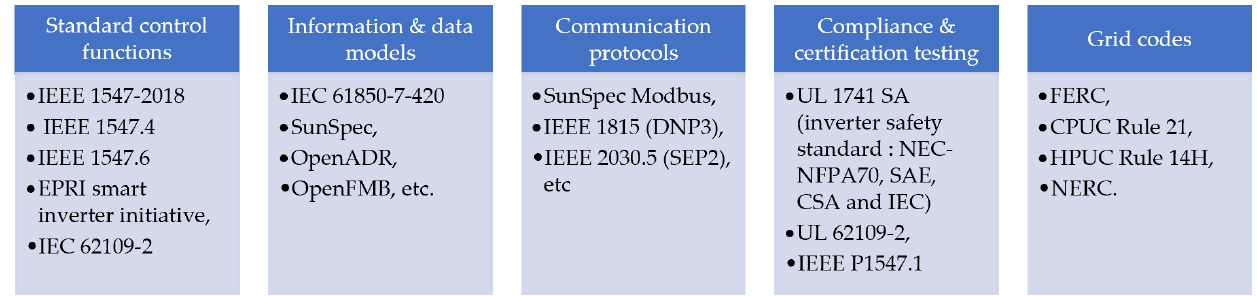
Figure 41. Smart inverter standards and grid codes.